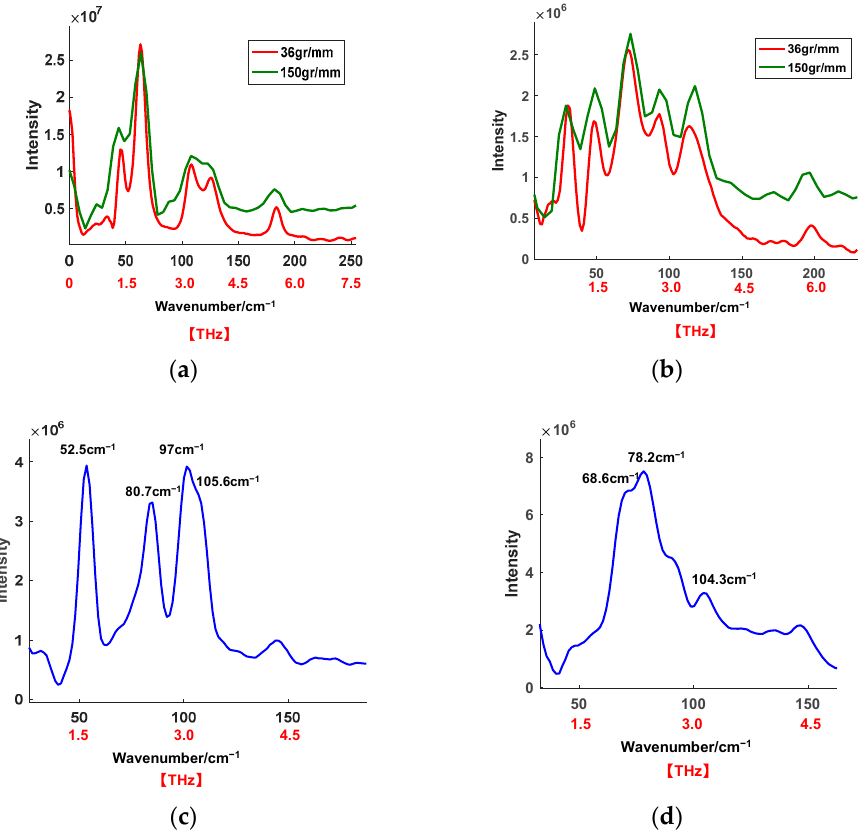
Figure 3. ( a ) Comparison of terahertz Raman spectra of salicylic acid; ( b ) comparison of terahertz Raman spectra of benzoic acid; ( c ) terahertz Raman spectrum of gallic acid; ( d ) terahertz Raman spectrum of p-aminobenzoic acid.